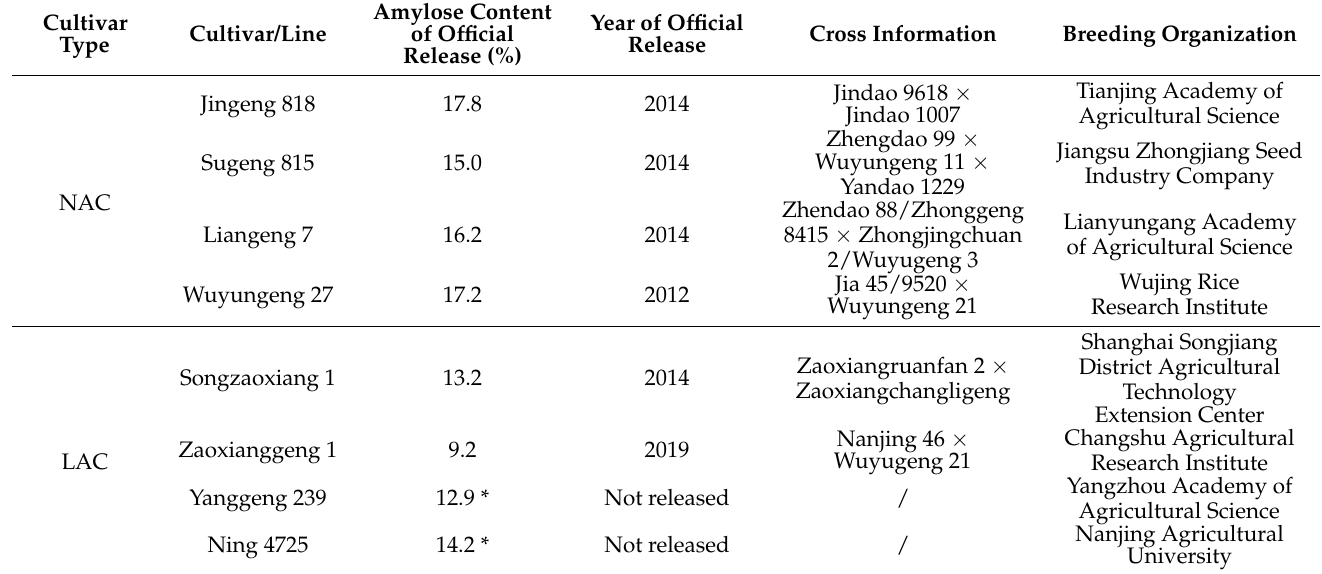
Table 1. The information on the japonica rice cultivars or lines with different contents of amylose. Cultivar Type